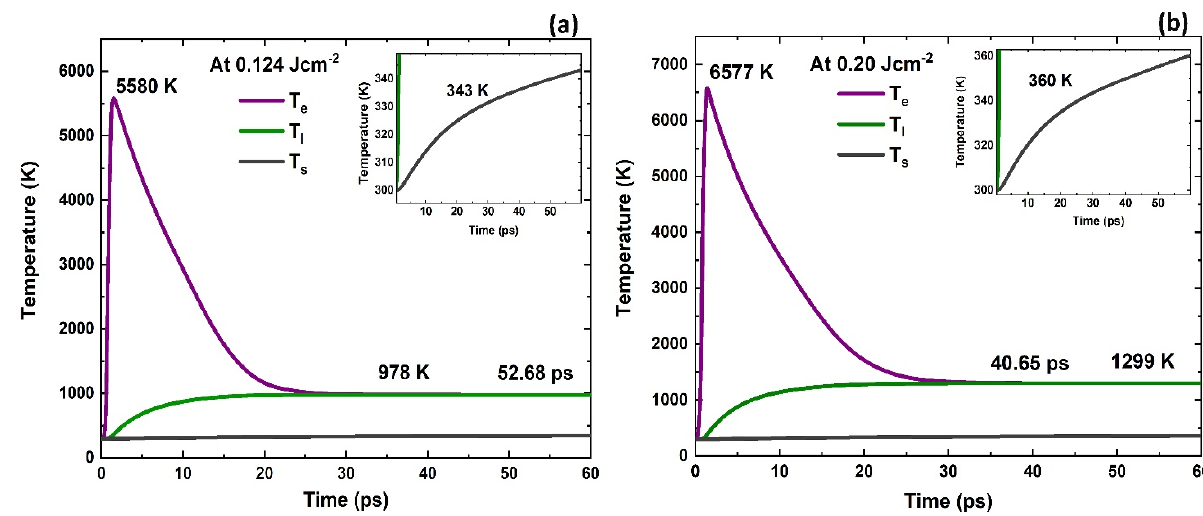
Figure 8. Surface temperature profiles as a function of time for 18-nm thick Au film on quartz, irradiated by 500 fs, 1030 nm pulse at ( a ) 0.124 Jcm − 2 and ( b ) 0.20 Jcm − 2 , respectively.